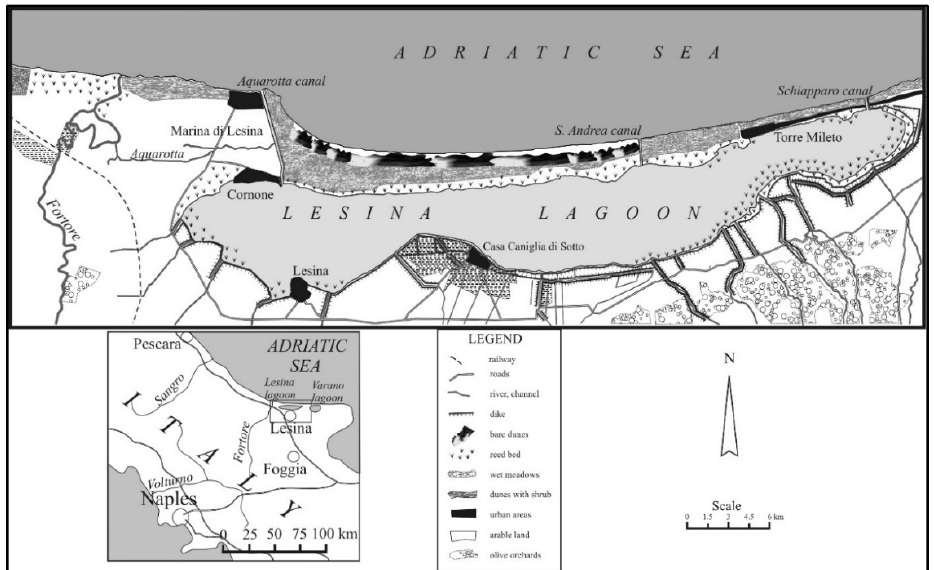
Figure 3. Lesina Lagoon. Source: authors’ own plotting.